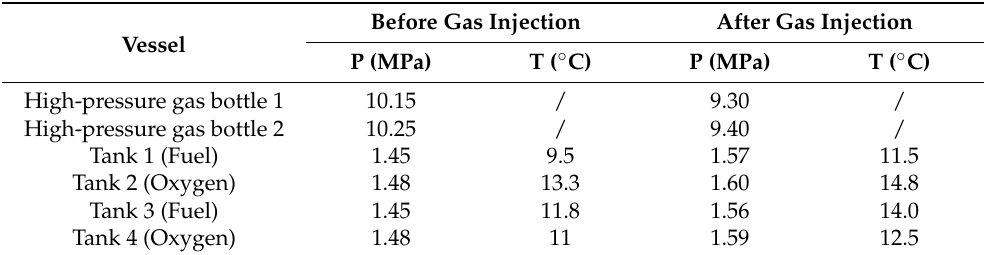
Table 1. Working conditions of PGS in FY-4. Before Gas Injection After Gas Vessel